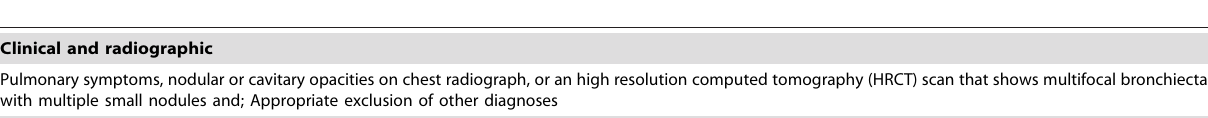
Table 1. American Thoracic Society diagnostic criteria on nontuberculous mycobacterial pulmonary disease.